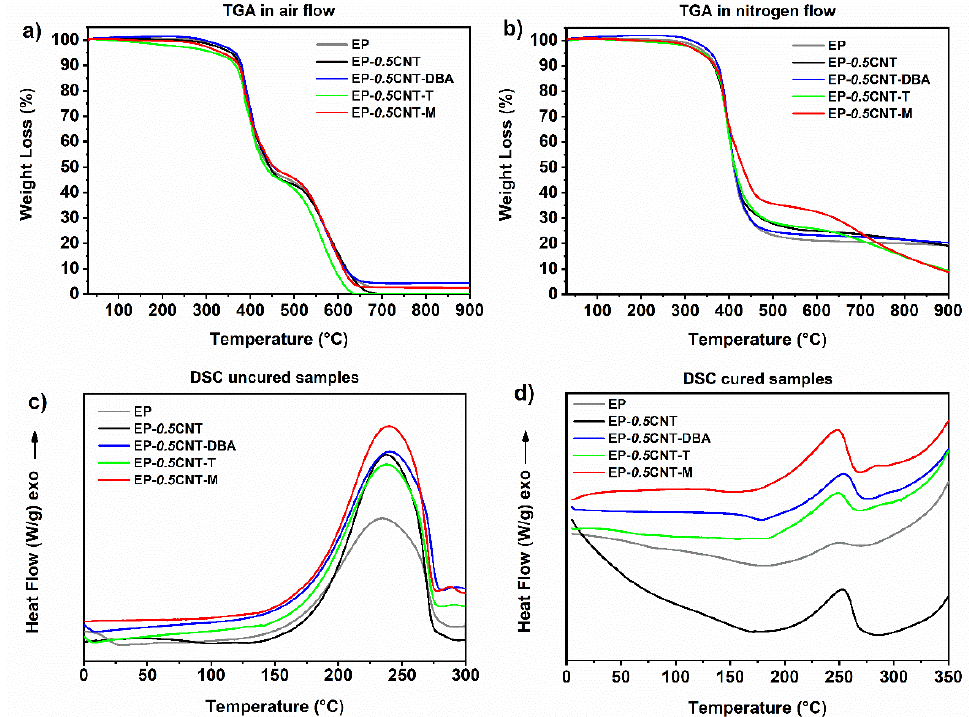
Figure 10. TGA curves of the oven cured epoxy formulations: ( a ) in air and in ( b ) nitrogen flow; ( c ) DSC curves of the raw epoxy formulations; ( d ) DSC curves of the cured epoxy formulations. As already seen for the systems loaded with the functionalized CNTs [24], the samples A DSC investigation was carried out to evaluate the DC (Equation (1)) of the hard ‐ manifest, in this range of temperature, a better thermal stability in air; the mass loss is ened formulations. Figure 10c,d show the DSC graphs of the uncured and cured samples, 52–57% in air and 69–76% in the inert environment, except for the system containing respectively. The DSC curves of Figure 10d evidence the exotherms in the range 175–280 °C, due to a small fraction of uncured resin. The DC of sample EP is 97%. The inclusion of CNTs in the samples results in a decrease in the value of DC ( DC = 89%), due to a lower crosslinking density; whereas for the sample loaded with both, the CNTs and the barbi ‐ turate fillers DBA and T, only a very slight decrease is detected in the values of DC , with respect to the value of 97% related to the matrix (see Table 2). Instead, for the epoxy nano ‐ composite filled with the filler M, a further decrease in the DC value, with respect to the unfilled formulation, is detected ( DC = 86%). Table 2. DSC data of the cured samples. Sample